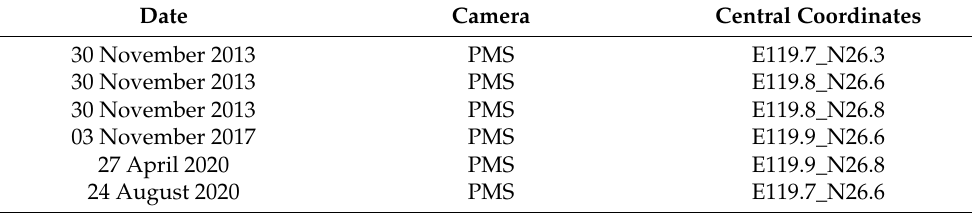
Table 2. Experimental data of